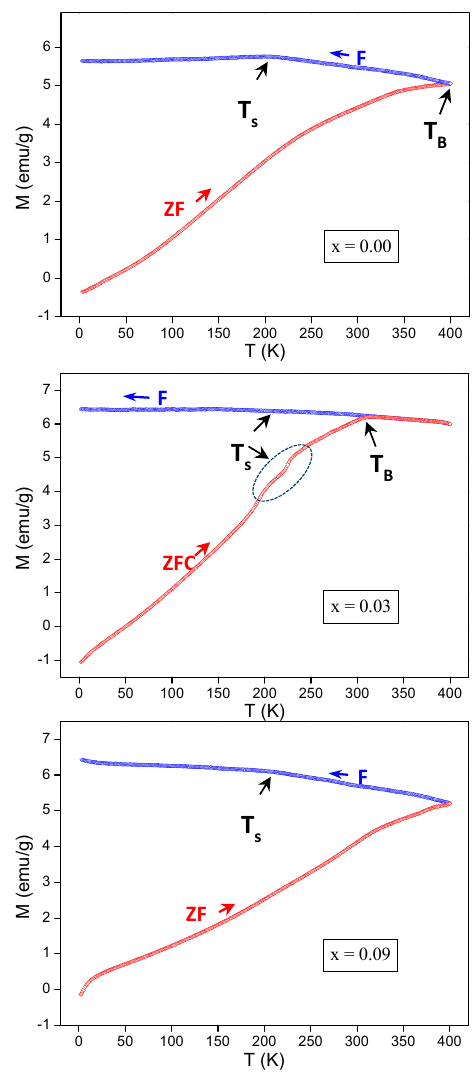
Figure 5. M ZFC (T) and M FC (T) curves of the three selected NPs.